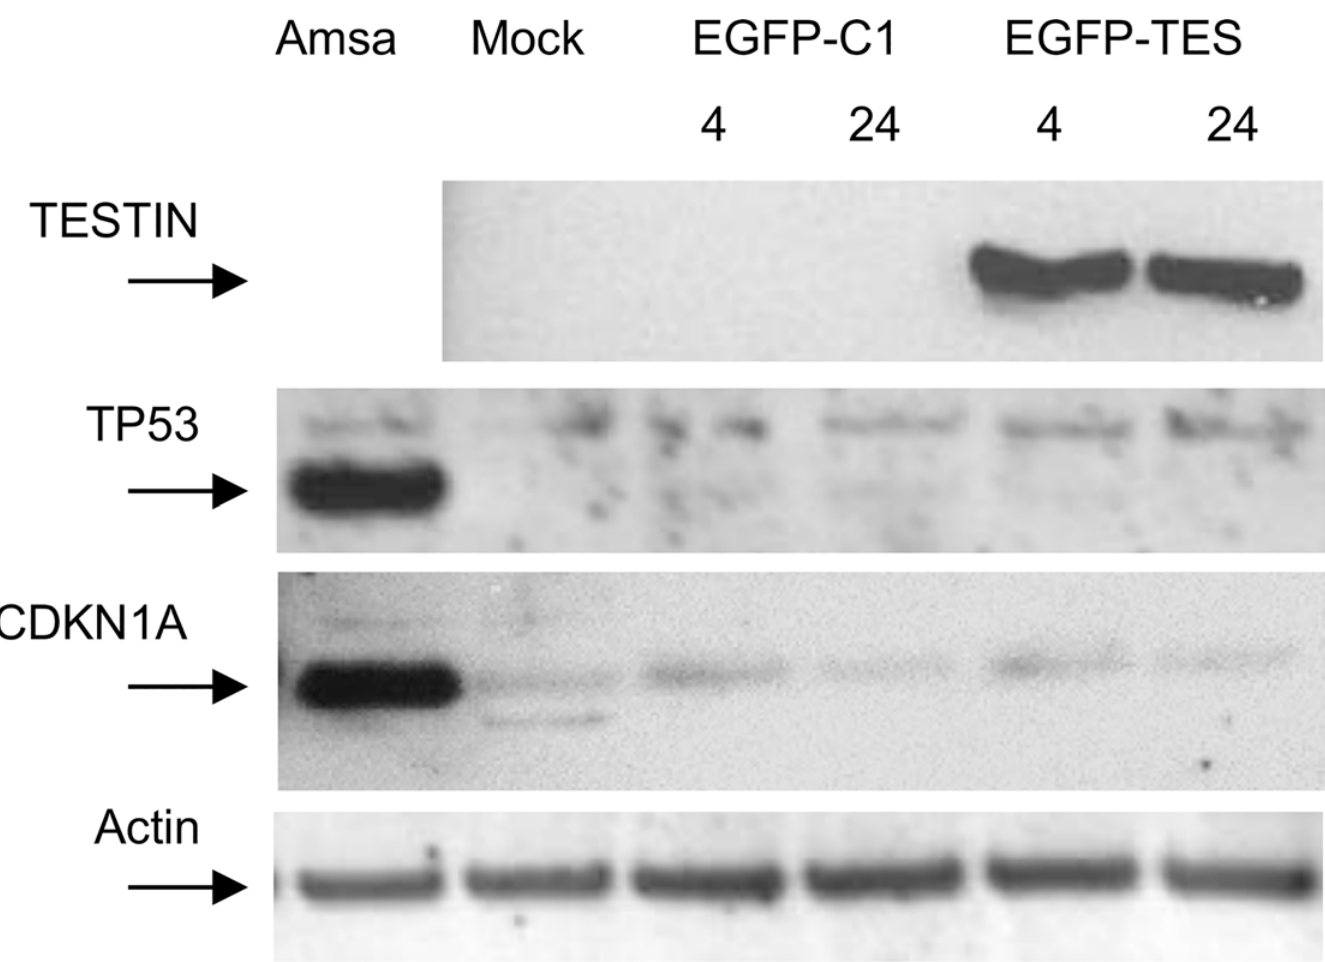
Fig 8. Immunoblots of transfected and amsacrine-treated NALM6 cells. Forty μ g of protein lysate from transfected and amsacrine-treated NALM6 cells were immunoblotted. EGFP-TESTIN fusion protein was detected using rabbit anti-TESTIN polyclonal antibody (Abcam: ab78499), and results showed rapid expression after transfection. Anti-TP53 monoclonal antibody (Cell Signalling) and anti-CDKN1A antibody (Santa Cruz Biotechnology) demonstrate lack of TP53 or CDKN1A induction after transfection, but robust induction after amsacrine exposure. Anti- α actin antibody was used to confirm equal protein loading.